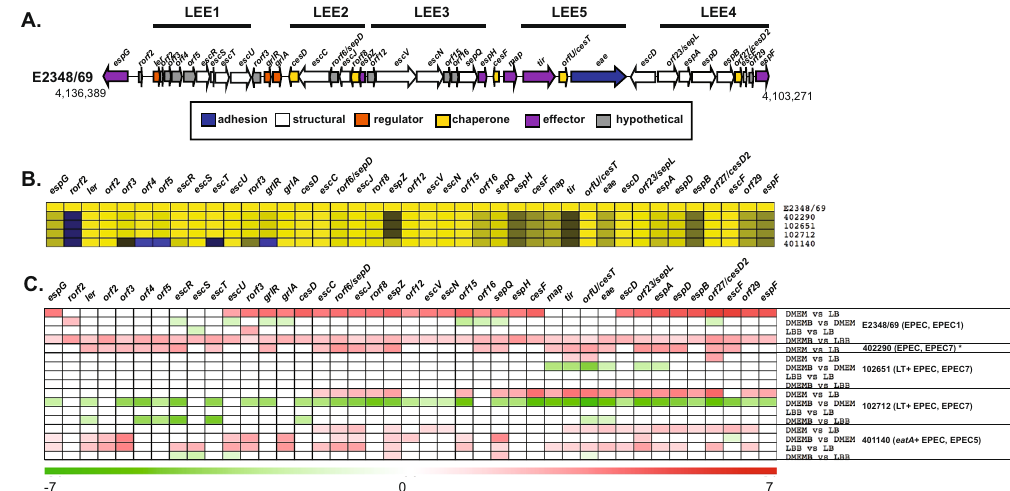
Figure 5. Differential expression of protein-coding genes within the LEE region. ( A ) Diagram of the protein- encoding genes within the LEE region of EPEC isolate E2348/69. The predicted protein function is indicated by the color of the arrow, and the size and direction of the arrows indicates the size of each predicted gene and the direction of transcription. ( B ) In silico detection of the protein-encoding genes of the LEE region of EPEC isolate E2348/69 in each of the EPEC genomes analyzed in this study. The colors of the heatmap represent the BSR values of each gene, with yellow indicating a gene is present, blue indicating a gene is absent, and grey to black indicating sequence divergence. ( C ) Heatmap of the differential expression for each of the sample comparisons of the EPEC isolates (E2348/69 and 402290) and the EPEC/ETEC hybrid isolates (102651, 102712, and 401140). Only significant LFC values ≥ 1 or ≤− 1 are represented in the heatmap. Red indicates increased differential expression while green indicates decreased differential expression. White indicates that a gene was either not present in the EPEC isolate, and/or did not exhibit significant differential expression. * The differential expression of EPEC isolate 402290 was previously investigated during growth in DMEM vs. LB (Hazen et al . unpublished) and was included as a reference comparison in the current study; however, this EPEC isolate was not grown in LB and DMEM with added